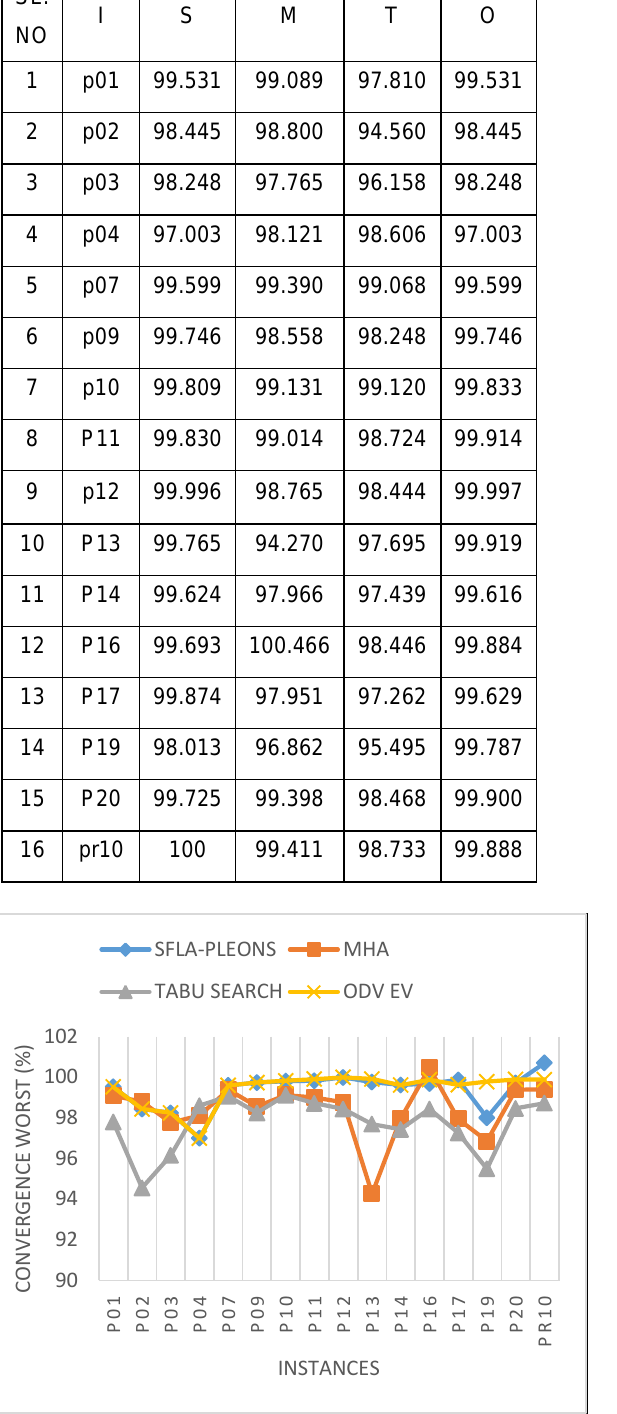
Table 2. Experimental results w.r.t Worst Convergence rate (%)